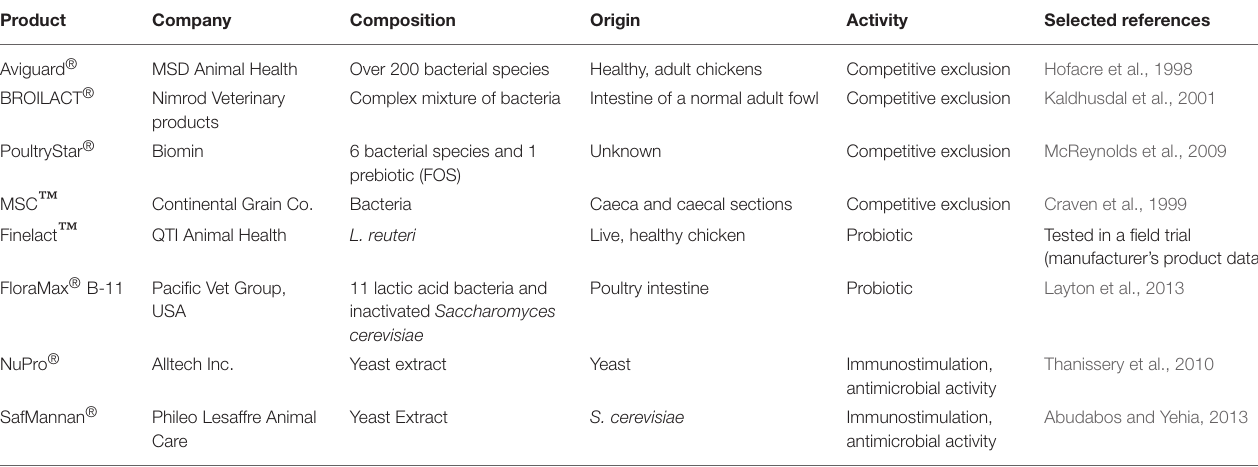
TABLE 1 | Examples of commercially available microbial feed additives for NE prevention in